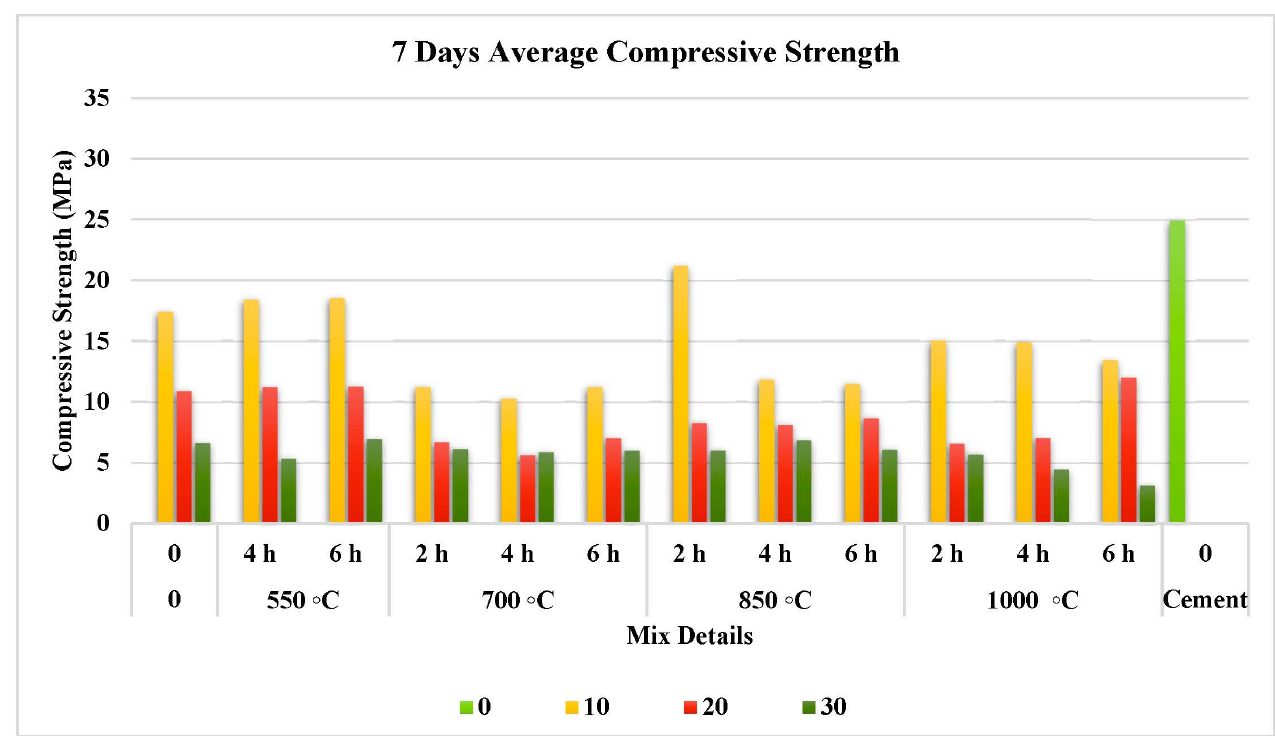
Figure 7. Effect of pre-treatment on 7 day compressive strength.